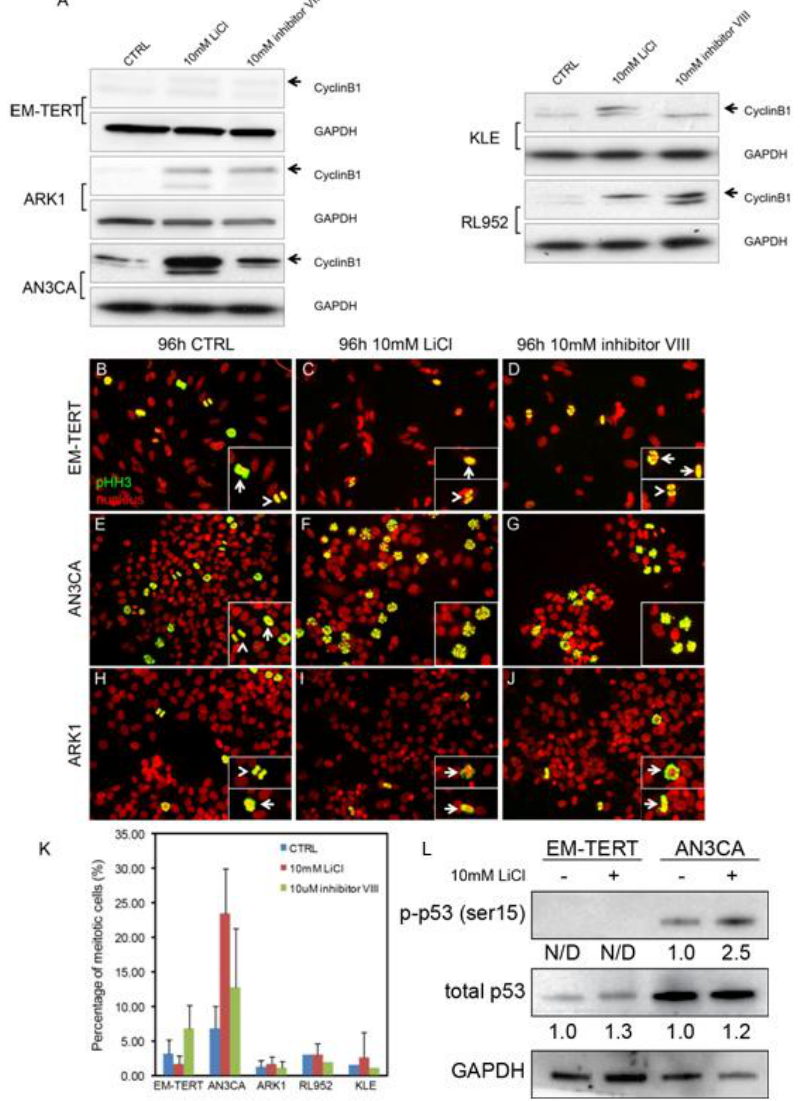
Figure 4. GSK3β inhibition-induced G2/M arrest is cell context-dependent. ( A ) Western blot on Cyclin B1 showed accumulation of this protein by either LiCl or GSK3β inhibitor VIII treatment for 96 h in multiple endometrial cancer cell lines without affecting the EM-TERT control cells; ( B – J ) Immunofluorescence of phospho-histone H3 (pHH3) showed accumulation of cells with staining pattern resembling that of the prophase cells in both LiCl- and GSK3β inhibitor VIII-treated AN3CA cells (F, G, insets). Note that normal mitotic cells at pro-/meta-phase (arrows) and ana-/telo-phase (arrowheads) in EM-TERT and ARK1 cells regardless of treatment ( B – D , H – J , respectively) as well as untreated AN3CA cells ( E ); ( K ) Quantification of pHH3-positive cells showed an increase in mitotic cell percentage only in AN3CA cells after anti-GSK3β treatments; ( L ) Western Blot showed that LiCl induced p53 activation (pSer15) only in the AN3CA cells, but not in the EM-TERT cells. Total p53 level was not significantly affected by LiCl treatment in either cell line. Fold-change of normalized p-p53 and p53 level comparing to untreated control is indicated. N/D: not